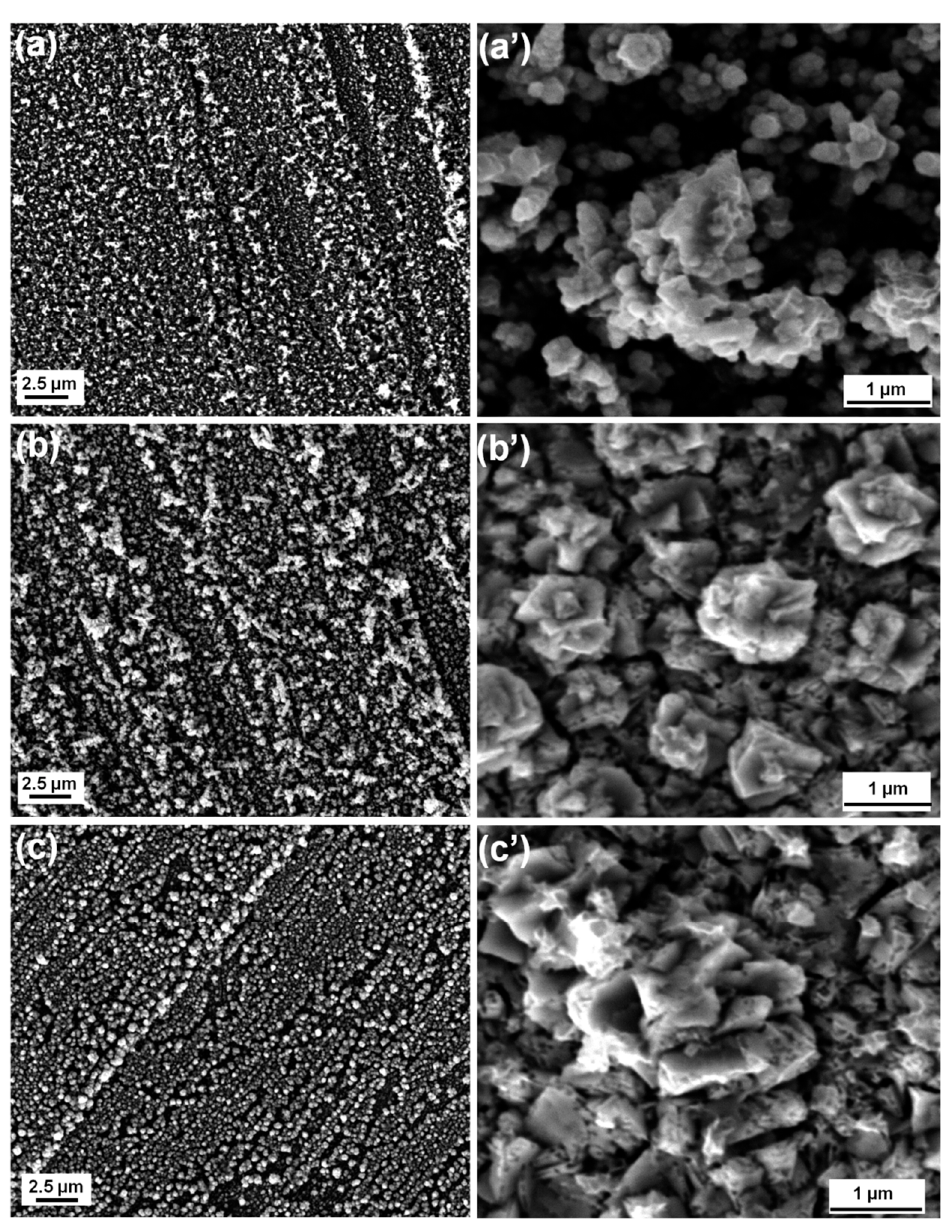
Figure 2. SEM images of the top surface of ( a ) Fe90s, ( b ) Fe180s, and ( c ) Fe300s with their corresponding highly magnified images in ( a’ ), ( b’ ), and ( c’ ). The XRD diffractograms of the substrate and the as-deposited samples are displayed in Figure 1. The samples show all peaks of Cu with an additional peak of bcc Fe (110) (denoted by the pink triangle). The peak positions of Cu have been shifted to the left as a result of layers of deposited Fe, which increased the overall thickness of the sample. On the other hand, peaks of Fe maintain their position since their position is always the same, i.e., on top of the sample. Other iron peaks are not clearly visible; only the most intense peak is seen, probably because the deposition layer was too thin. Additionally, there are no peaks attributable to iron oxides. Based on these results, it is clear that mainly metallic Fe has been deposited on the copper